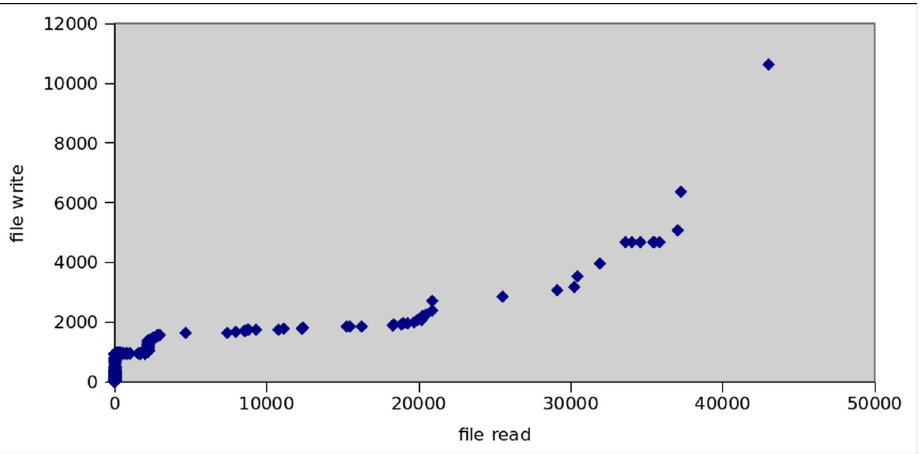
Fig 17. Average File Read/Write operations by